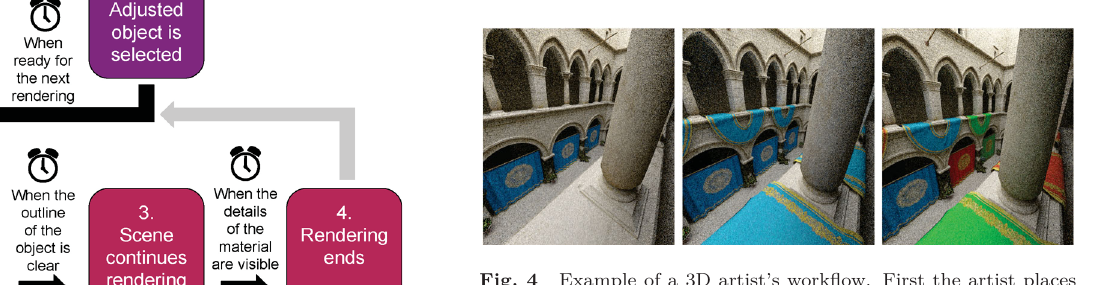
Fig. 4 Example of a 3D artist’s workflow. First the artist places U-shaped cloths, which might require many previews of the positioning with the slow progressive rendering method, especially if the objects are transparent or reflective. Then the artist modifies the material of the objects and previews the